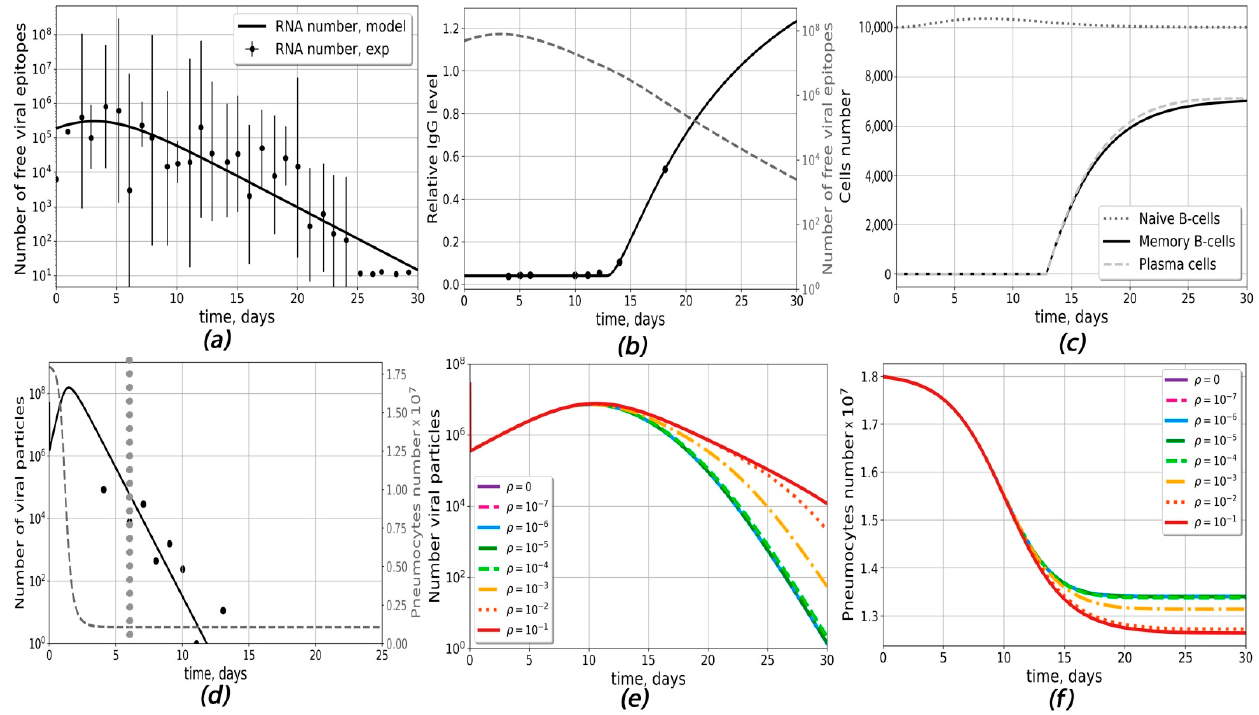
Figure 1. Antibody-response generation (model Ab) and infection propagation (model Cv)